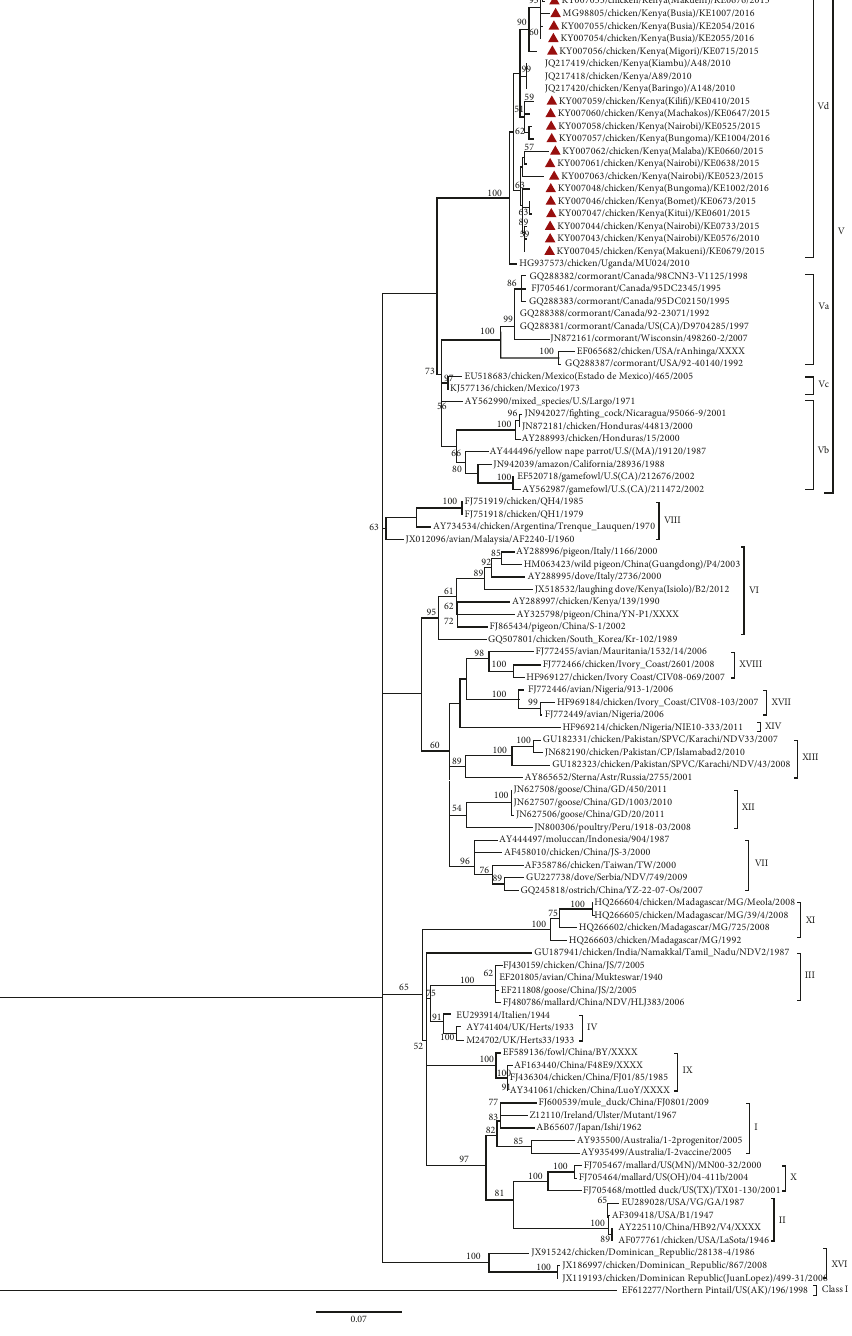
Figure 2: Phylogenetic tree of partial fusion (F) gene nucleotide sequences of the Newcastle disease virus- (NDV-) positive study samples () and GenBank references. The percentage of replicate trees in which the associated taxa clustered together in the bootstrap test (1000 replicates) is shown next to the branches (only > 50% is shown). The evolutionary history was inferred by using the maximum likelihood method based on the Kimura 2-parameter model. The gamma correction for rate heterogeneity was 0.4292. The analysis involved 111 nucleotide sequences. The tree is rooted using the NDV sequence belonging to Class I. There were a total of 521 positions in the final dataset. Evolutionary analyses were conducted in MEGA 6